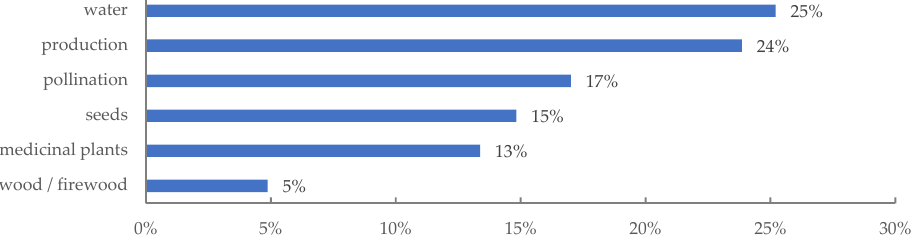
Figure 11. Perception of the other impacts related to drought (Source: prepared by the authors).